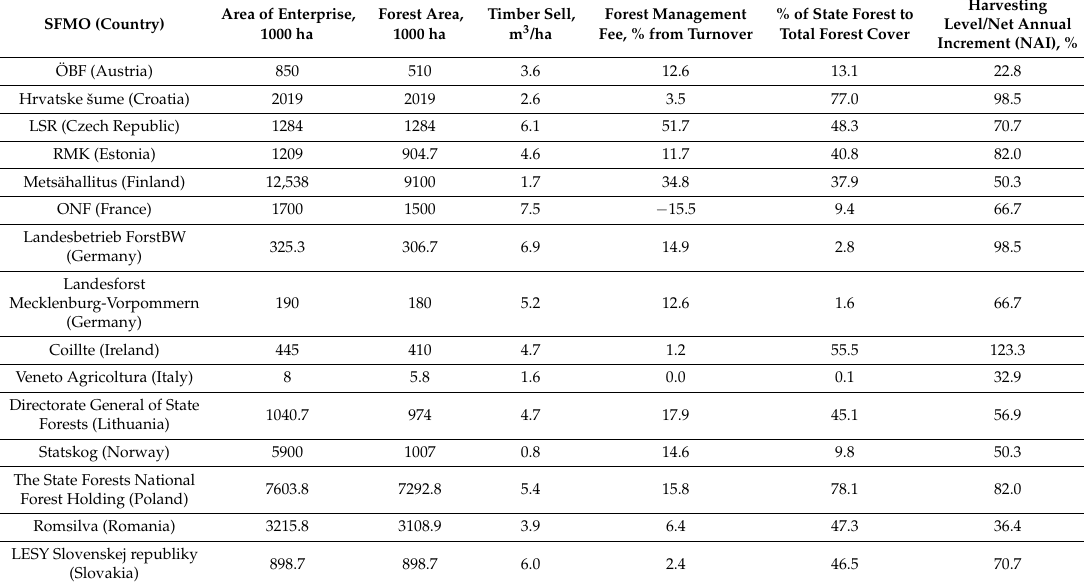
Table 3. Selected data concerning analyzed SFMOs (own